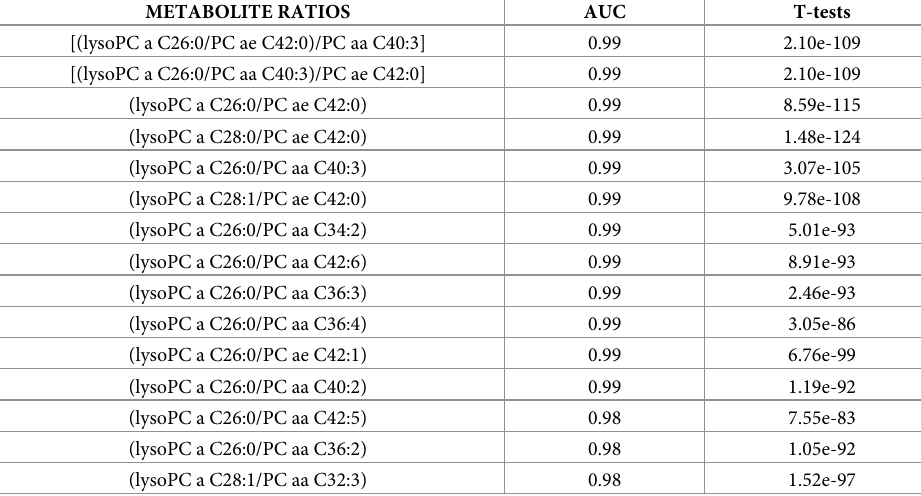
Ratios utilized in multivariate ROC curve analysis 100-fold Cross Validation = 0.99, Permutation Test Statistics = p <